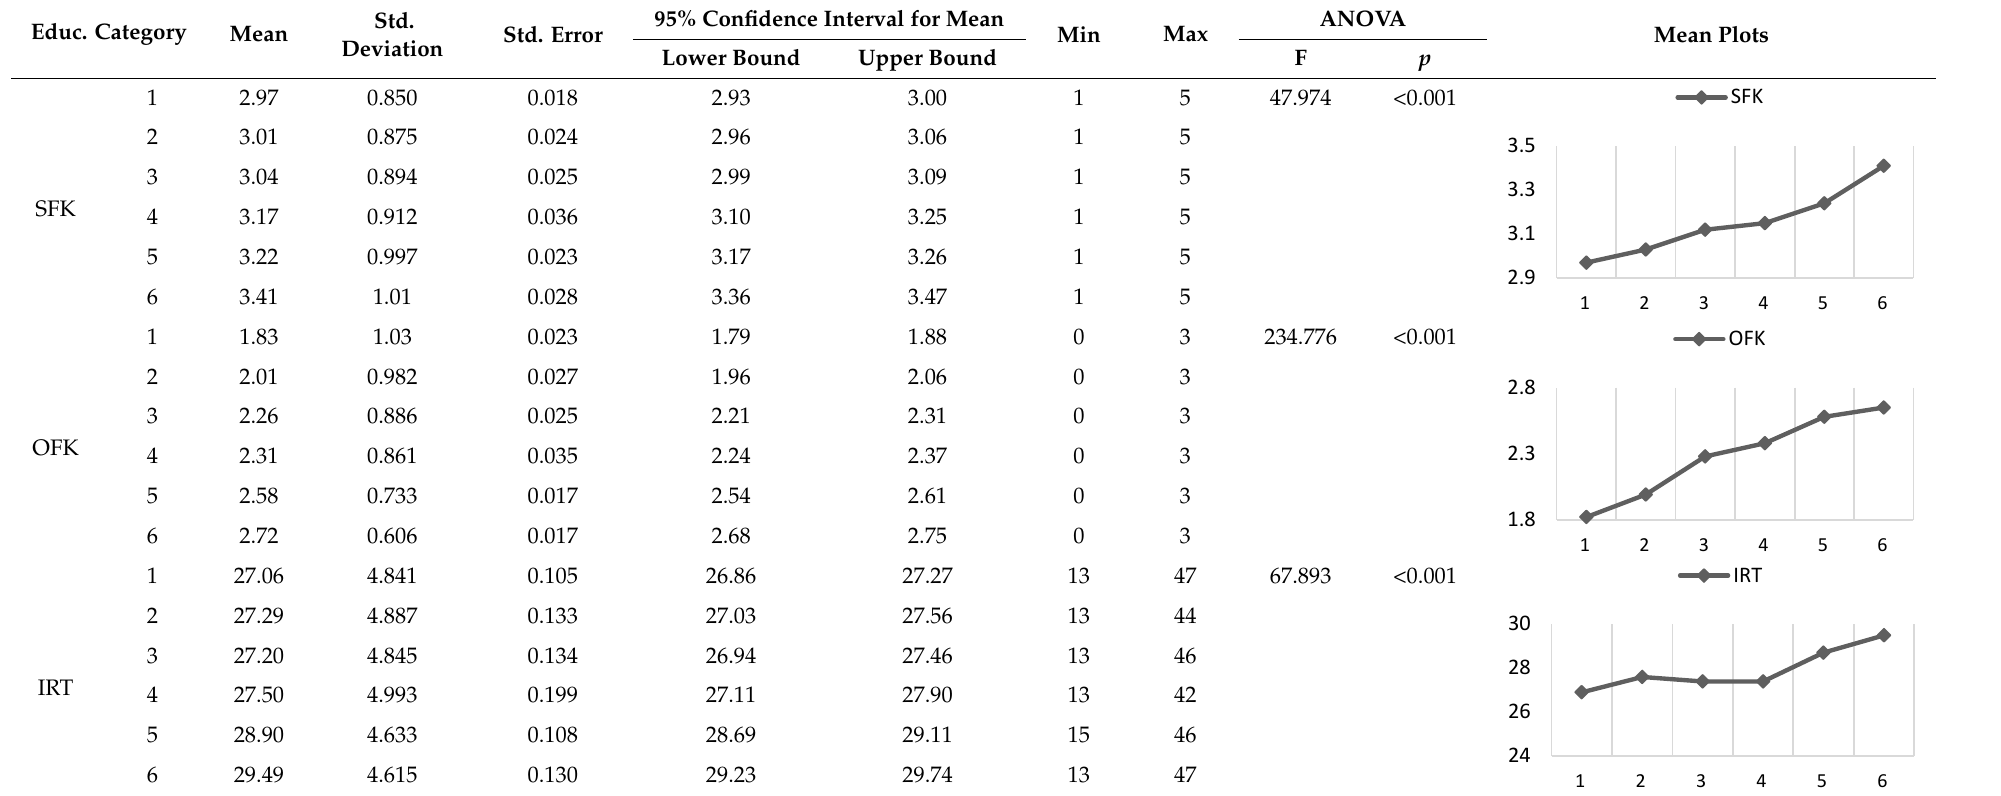
Table 5. Financial Knowledge and Investment Risk Tolerance Comparisons Across Education Categories (N = 8038). Educ. Category